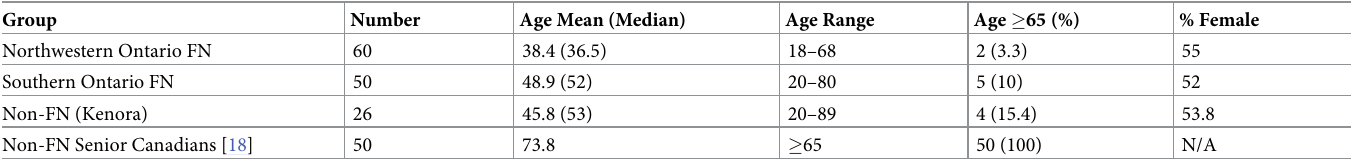
Table 1. Demographics of study participants.